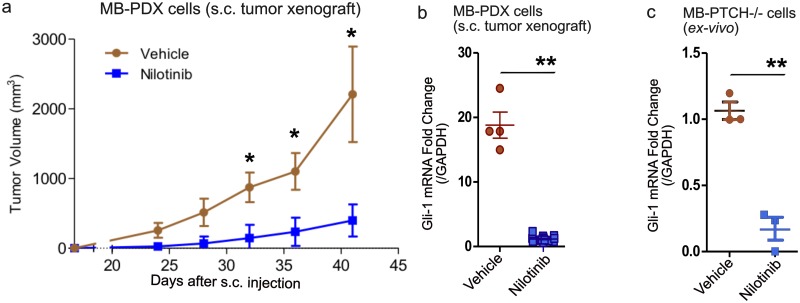
Nilotinib reduces tumor growth and Gli-1 mRNA expression in-vivo.(a) Nilotinib treatment (40 mg/kg/day) led to significant reduction in tumor volume as compared to vehicle treated group in the MB-PDX xenograft model (n = 2). (b) Gli-1 mRNA expression is reduced in Nilotinib (10 μM) treated tumors as compared to vehicle treated tumors of MB-PDX xenograft model (n = 3). (c) Gli-1 mRNA expression is decreased in the MB (Math1-Cre; ptch1-flox/flox) cells propagated in mice and treated ex-vivo with Nilotinib (10 μM) in ultra-low attachment plates for 24 hours (n = 3). Data represent the mean and standard deviation for repeat experiments, and asterisks represent p-values as follows: *, p < 0.05; **, p < 0.005.